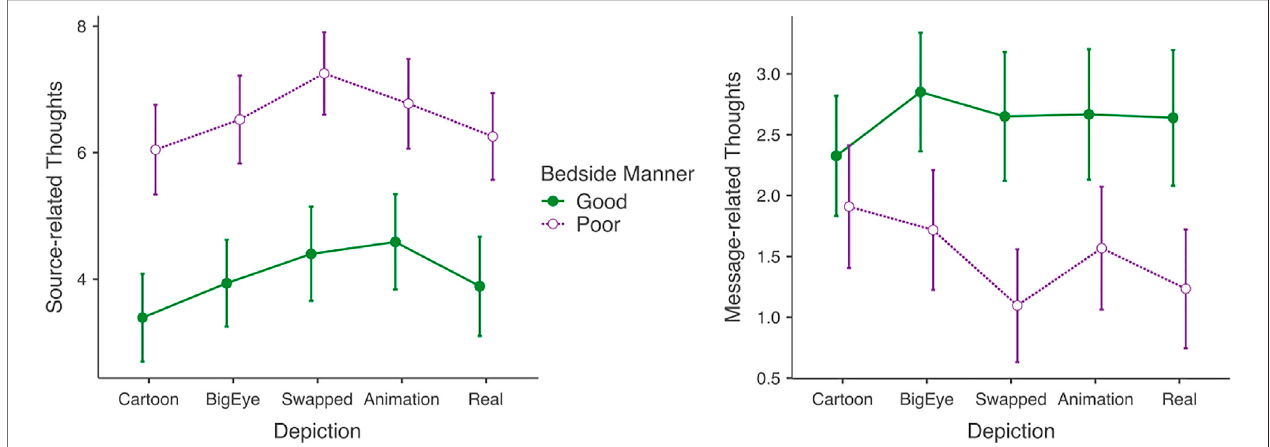
Frontiers in Virtual Reality |